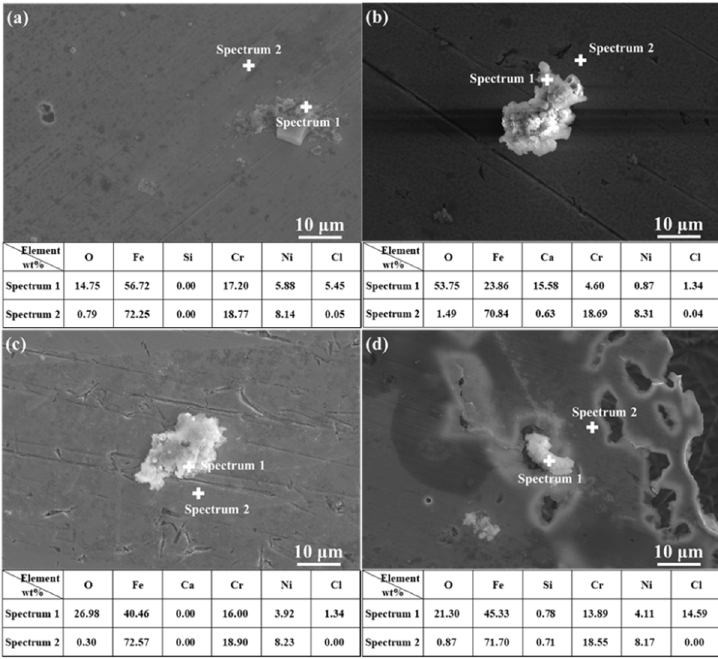
Figure 4. The EDS analysis of 304 stainless steel treated by polarization measurements in different solutions: ( a ) SG; ( b ) SG + CaCl 2 ; ( c ) SG + Na 2 CO 3 ; ( d ) SG + Na 2 SiO 3 .